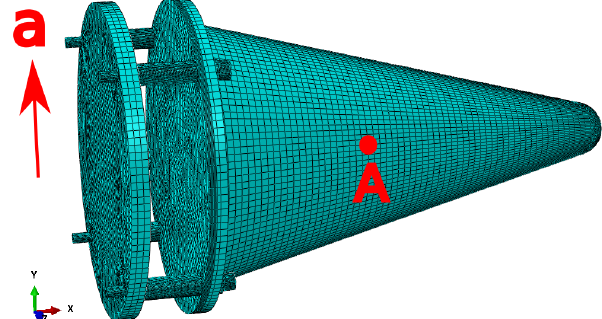
Figure 11. Loading skeme.